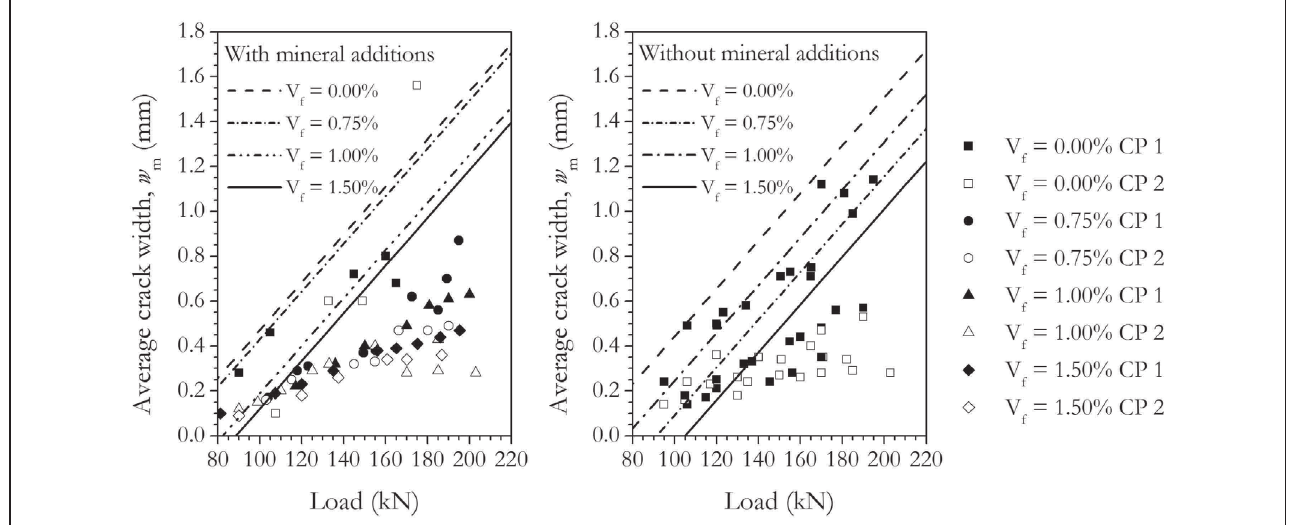
Figure 5 – Average main crack width – comparison between experimental and calculated according to Eurocode 2 values for concretes with and without mineral